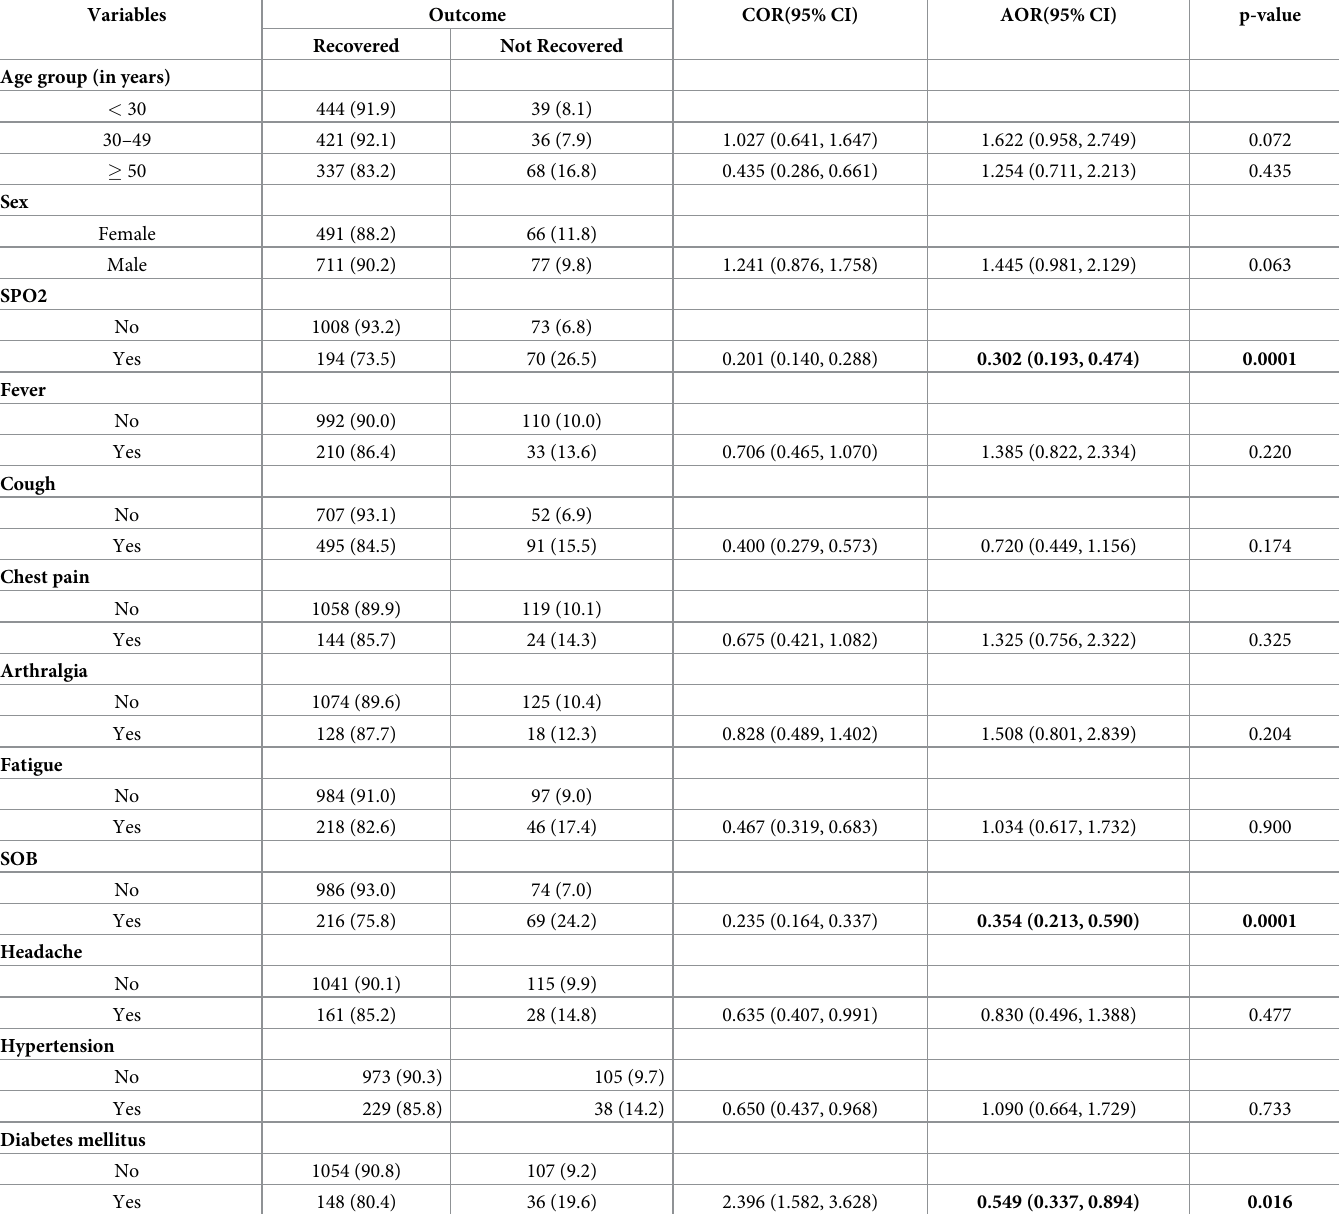
Table 3. Results for the final multiple binary logistic regression model among patients with COVID-19 (n = 1345). Variables